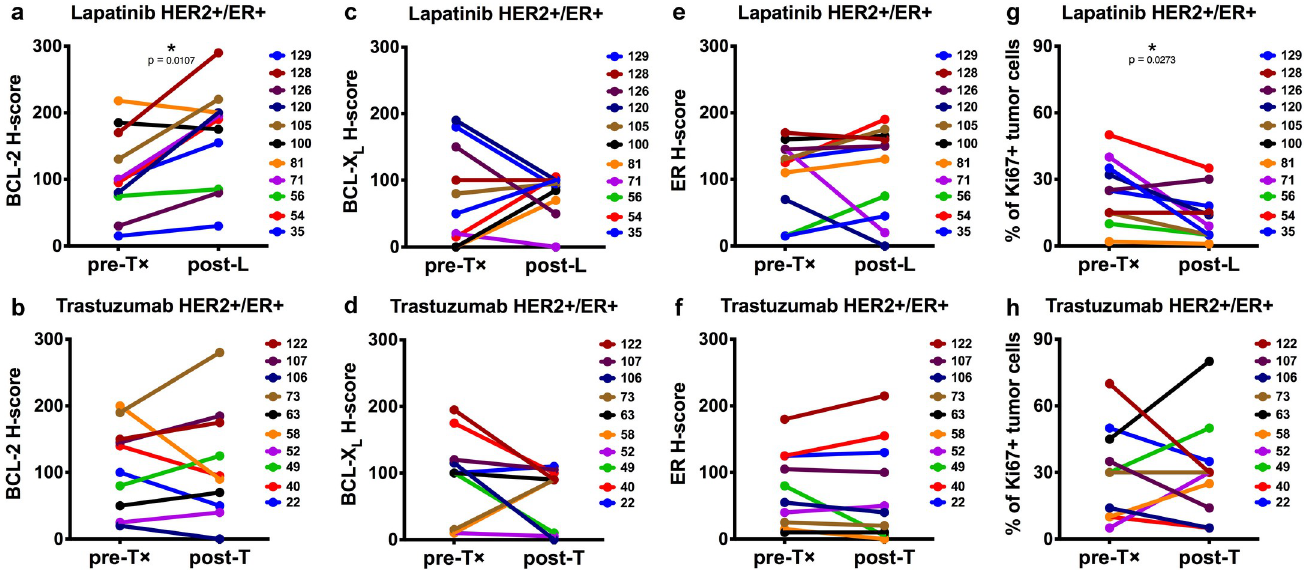
Fig 4. [HER2+/ER+] comparison of BCL-2, BCL-X L , ER and Ki67 protein levels pre- and post-lapatinib [L] or post-trastuzumab [T] treatment. Eleven HER2 +/ER+ lapatinib-treated and ten HER2+/ER+ trastuzumab-treated sample pairs were evaluated for BCL-2 ( a and b ), BCL-X L ( c and d ), ER ( e and f ) and Ki67 ( g and h ). BCL-2, BCL-X L , ER and Ki67 were evaluated as described in Fig 3. Each numerical identifier represents a clinical sample pair. Each plot compares baseline (pre- treatment) and run-in (post-treatment) paired samples. Statistical comparisons utilized Wilcoxon matched-pairs signed rank two-tailed test and p-values < 0.05 are indicated ( � ). p-values = [ a ] 0.0107; [ b ] 0.9922; [ c ] 0.9727; [ d ] 0.2207; [ e ] 0.4521; [ f ] 0.8945; [ g ] 0.0273; [ h ] 0.9297.